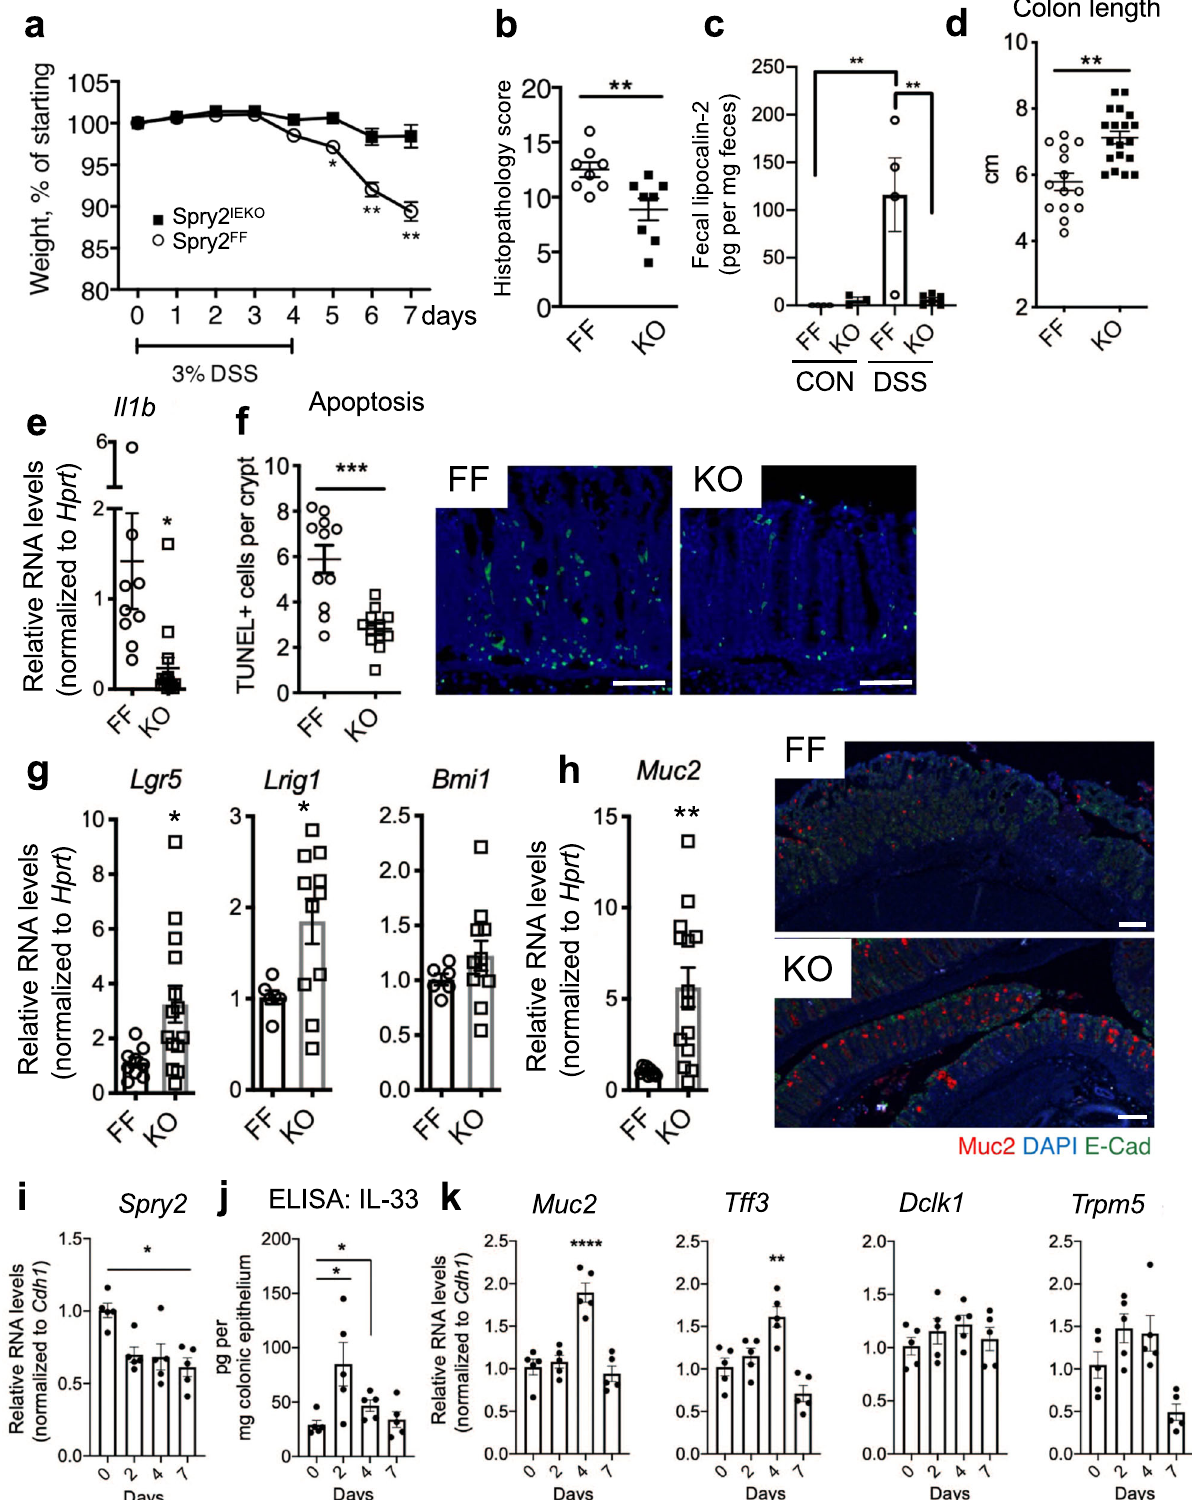
the broader in fl ammatory milieu of colitis, thus permitting us to directly test its function. Spry2 IEKO mice showed increased numbers of secretory tuft and goblet cells, but not enteroendo- crine cells or absorptive enterocytes. We speculate this induction may be a compensatory skewing toward cell types that are pro- tective in mouse models of colitis 4,5,52 and in patients with IBD 53